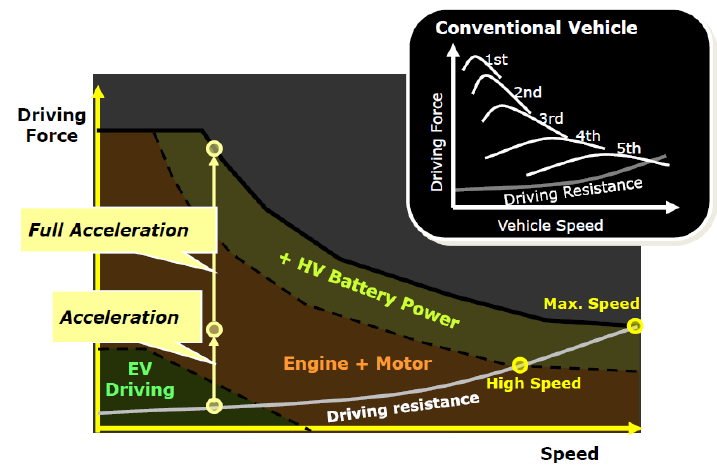
Figure 10. Driving force vs . speeds for the hybrid system. Source [35].